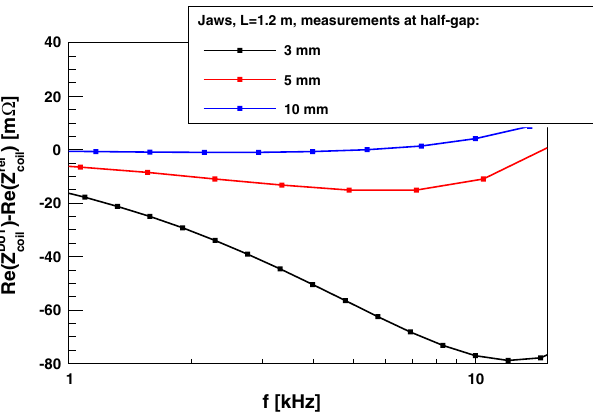
FIG. 12. (Color) Amplitude of the observable (cid:3) ½ Re ð Z DUT coil Þ (cid:1) Þ(cid:2) as measured for stand-alone jaws at low frequency Re ð Z ref coil for different gaps. The red curve (half-gap ¼ 5 mm ) corresponds to the same case as the measurements of Fig. 11.